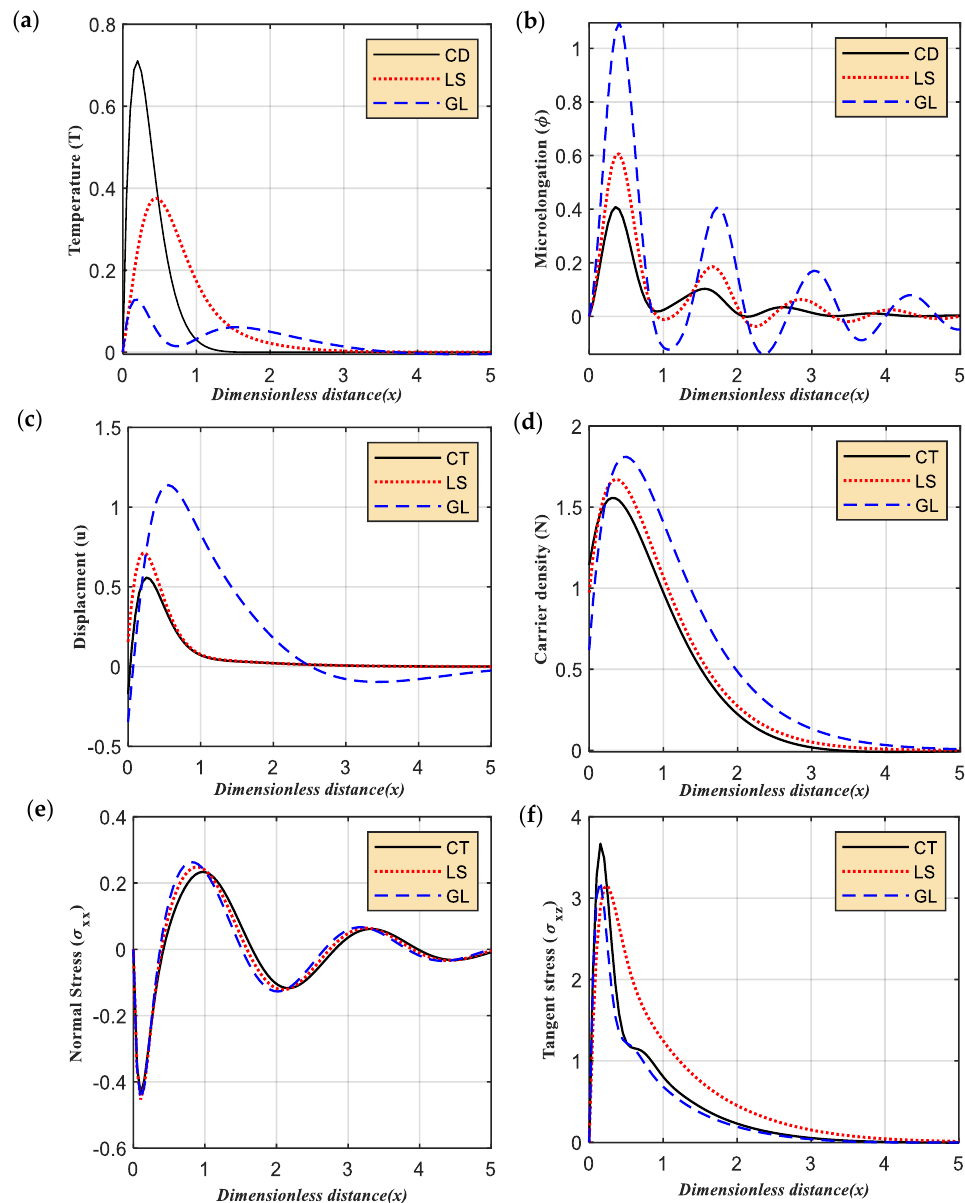
Figure 2. ( a – f ) The variation of the main physical fields versus the horizontal distance according to the differences in thermal relaxation times under the effect of rotation parameters.